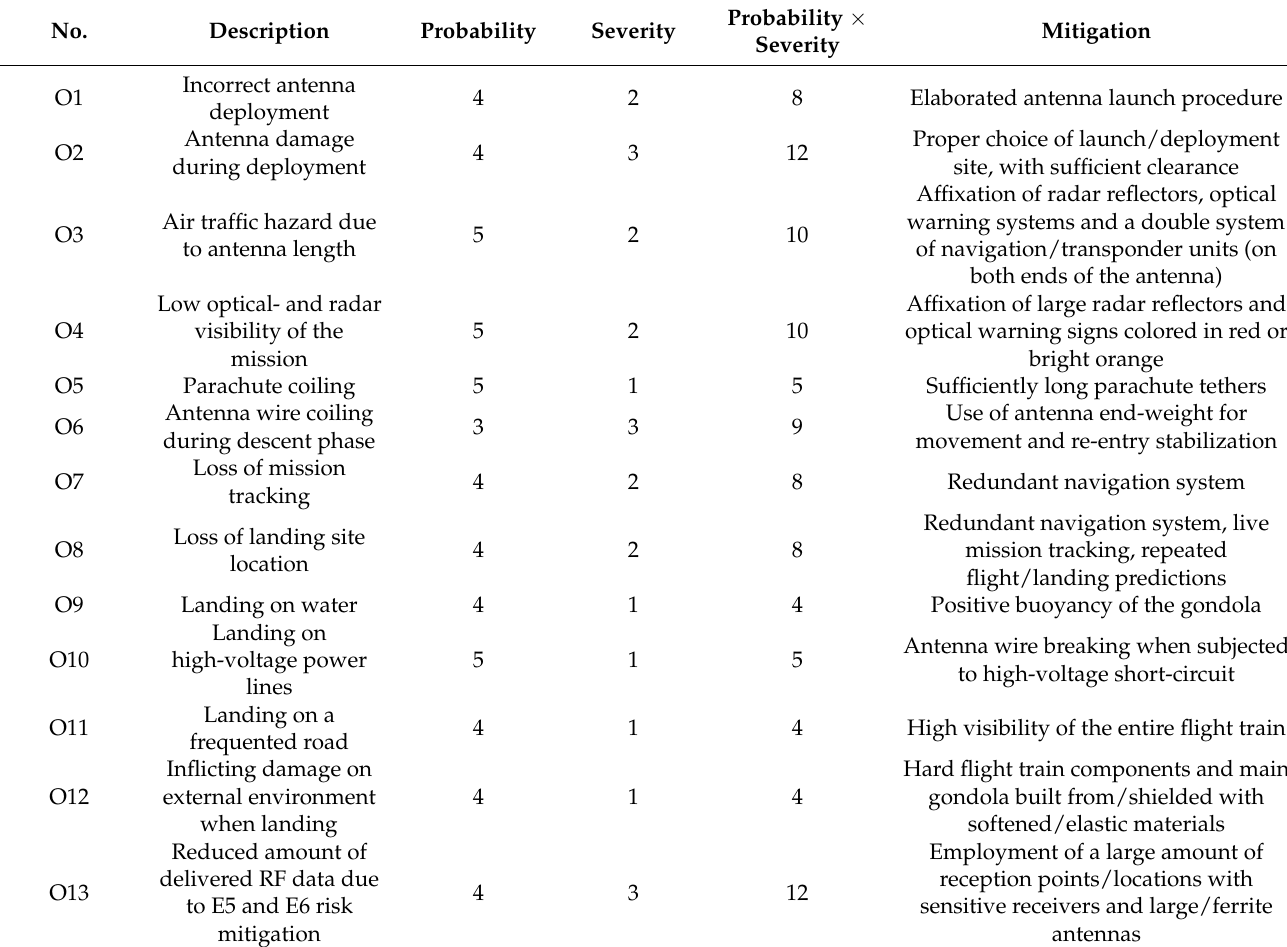
Table 5. Operational risks for a stratospheric fully airborne VLF light balloon